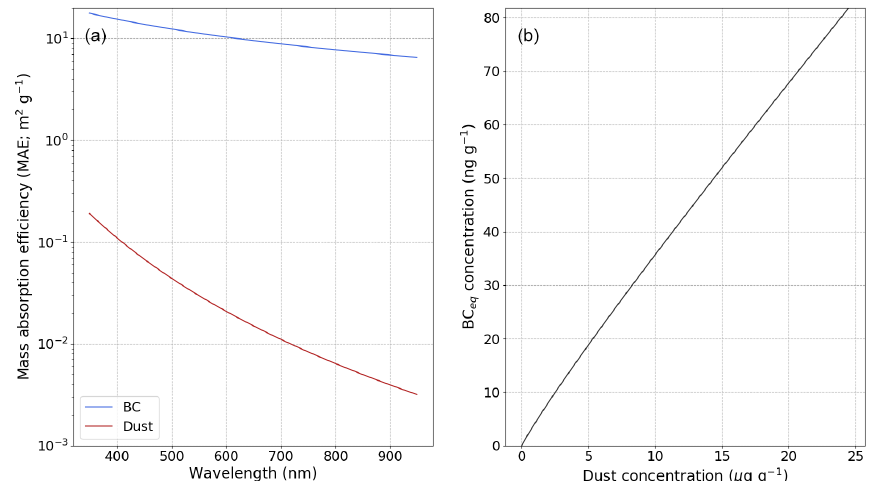
Figure A1. (a) Mass absorption efficiency (MAE) values of BC and dust used in the present study as a function of wavelength. (b) EqBC concentration corresponding to a given dust concentration using these MAE values and the methods described in Sect. 2.4. The figure is adapted from Tuzet et al. (2019).